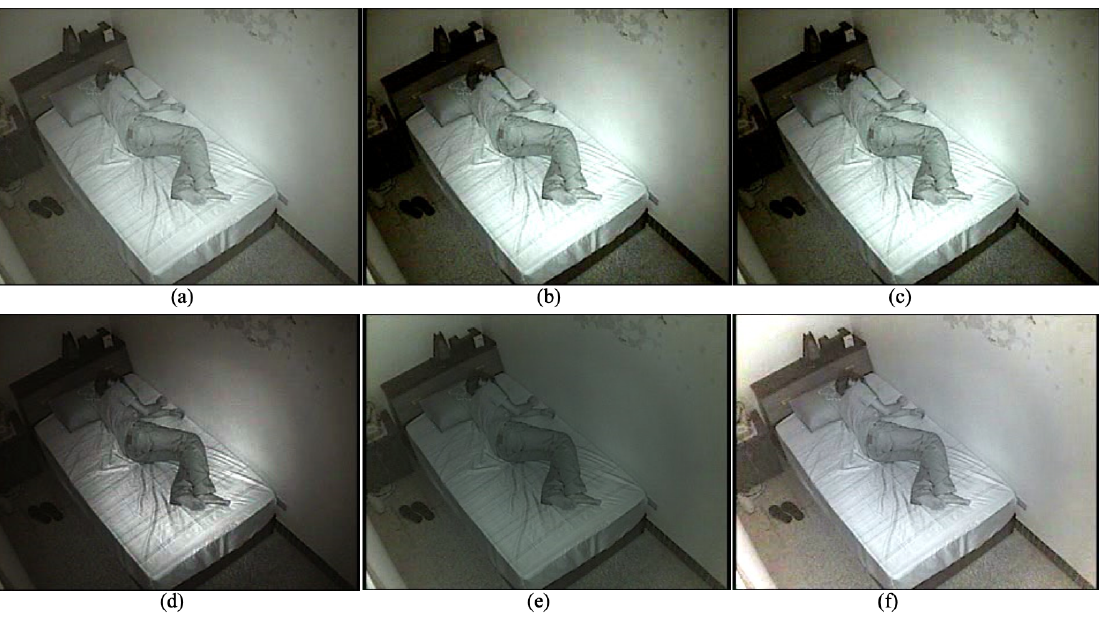
Figure 5. Enhancement of NIR images. ( a ) Original image. ( b ) Histogram stretching. ( c ) Histogram equalization. ( d ) Gamma correction. ( e ) Single-scale Retinex. ( f ) The proposed illumination compensation method.